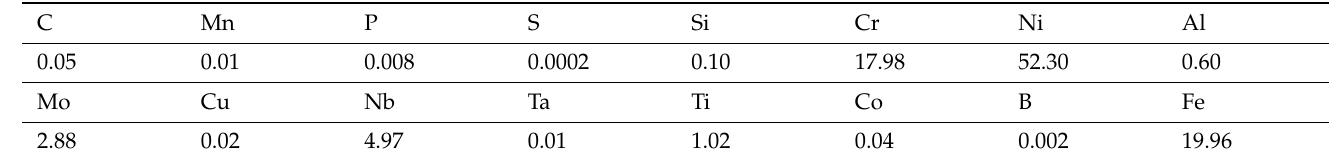
Table 1. Chemical composition of the Inconel 718 alloy (% weight).